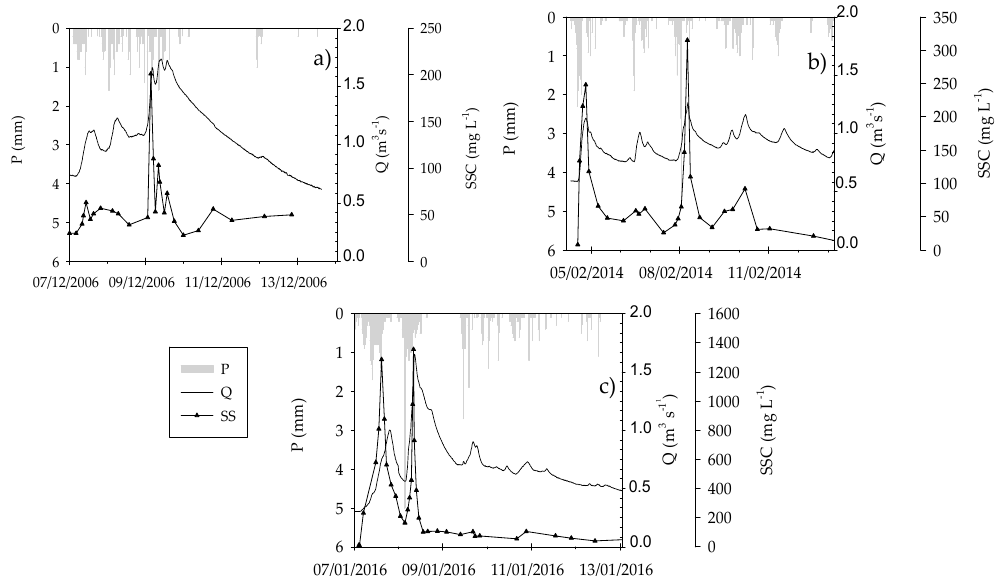
Figure 8. Rainfall (P), discharge (Q) and suspended sediment concentrations (SSC) during some events registering high suspended sediment load. ( a ) 7–13 December 2006; ( b ) 4–13 February 2014; ( c ) 7–13 January